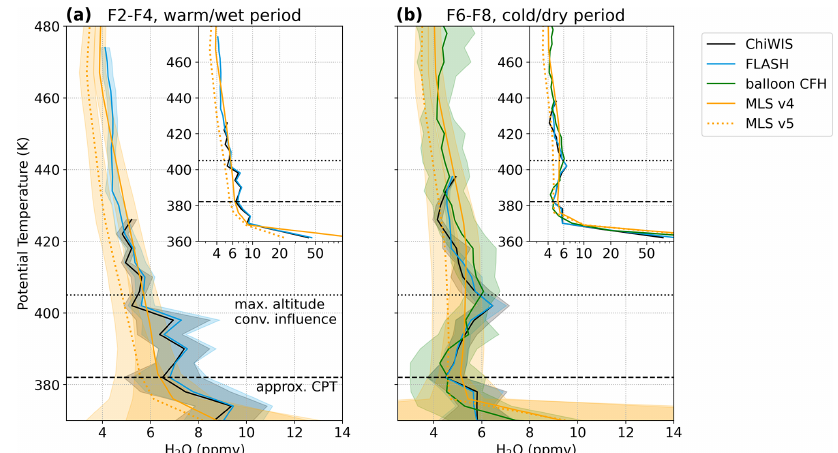
Figure 9. Mean all-sky water vapor profiles against potential temperature as measured by the aircraft hygrometers ChiWIS (black) and FLASH (blue), balloon-borne cryogenic frost point hygrometer (CFH, green), and satellite microwave limb sounder (MLS, yellow) versions 4 and 5 (solid/dashed), with standard deviation shown as the shaded region. Panel (a) shows the warm/wet period of the campaign from 27 July to 3 August (F2–F4), and (b) shows the cold/dry period from 4 to 10 August (F6–F8). FISH is not shown because it measures total water inside of clouds, while the other instruments measure only gas-phase water vapor. The CFH profile is constructed from 11 balloon soundings during the cold/dry period of the campaign and the MLS v5 (v4) profiles from 70 (65) retrievals in the warm/wet period and 56 (53) in cold/dry period, over a region encompassing the flight tracks (shown in Fig. 1). Insets show mean profiles over a wider range of H 2 O mixing ratios, up to 100ppmv. The heavy dashed line shows the approximate cold-point tropopause (CPT); in both periods this coincides with the minimum measured water vapor. The dotted black line shows the approximate maximum level of convective influence. Water vapor profiles above this line are similar in both periods while the UTLS below varies dramatically. The MLS profiles still capture this temporal change despite their lower vertical